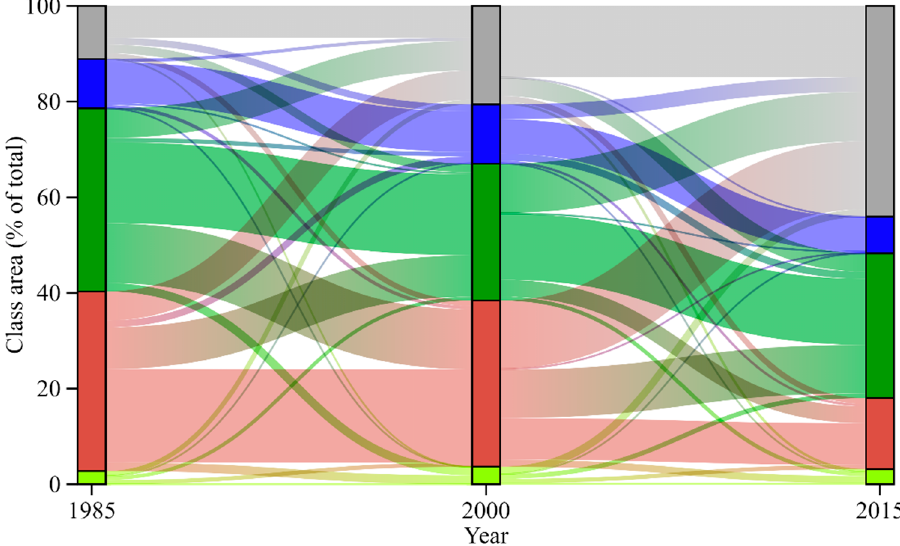
Figure 5. The modified Sankey chart to visualize the state and change flows of the land use and land cover (LULC) classification for Z01 from 1985 to 2015 in Nanjing (colors and classes of the Sankey charts produced in this study are the same as in Figure 4).